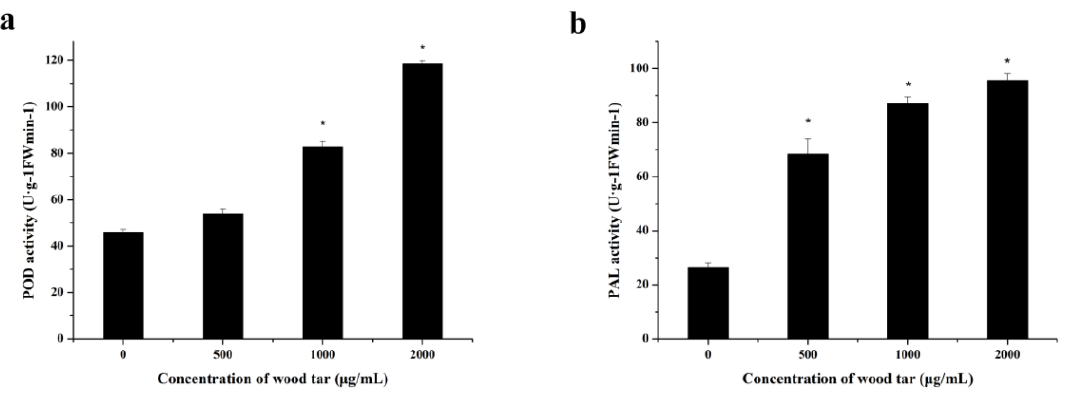
Figure 5. Effect of wood tar on the POD ( a ) and PAL ( b ) activity in apple leaves. Bars denote the stand errors of three experiments. Asterisk denotes significantly different from the control according to Student’s t -test: * p <